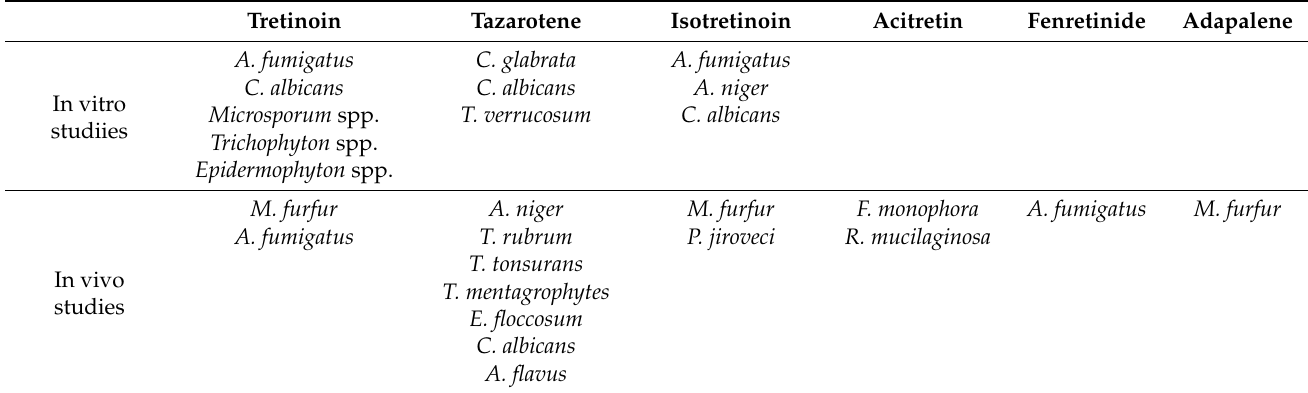
Table 2. Evaluation of retinoid efficacy against mycosis.